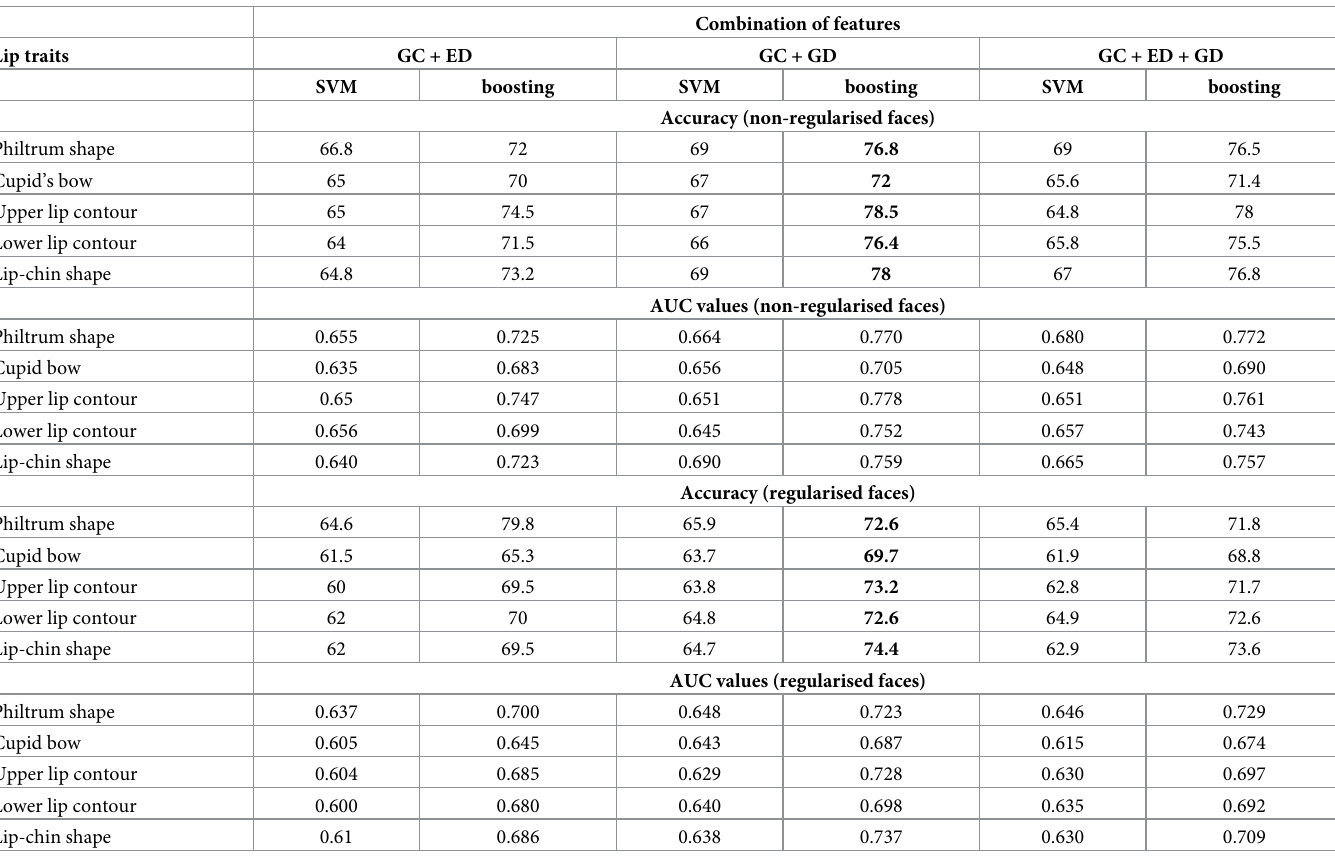
Table 6. Classification results based on different combinations of features.